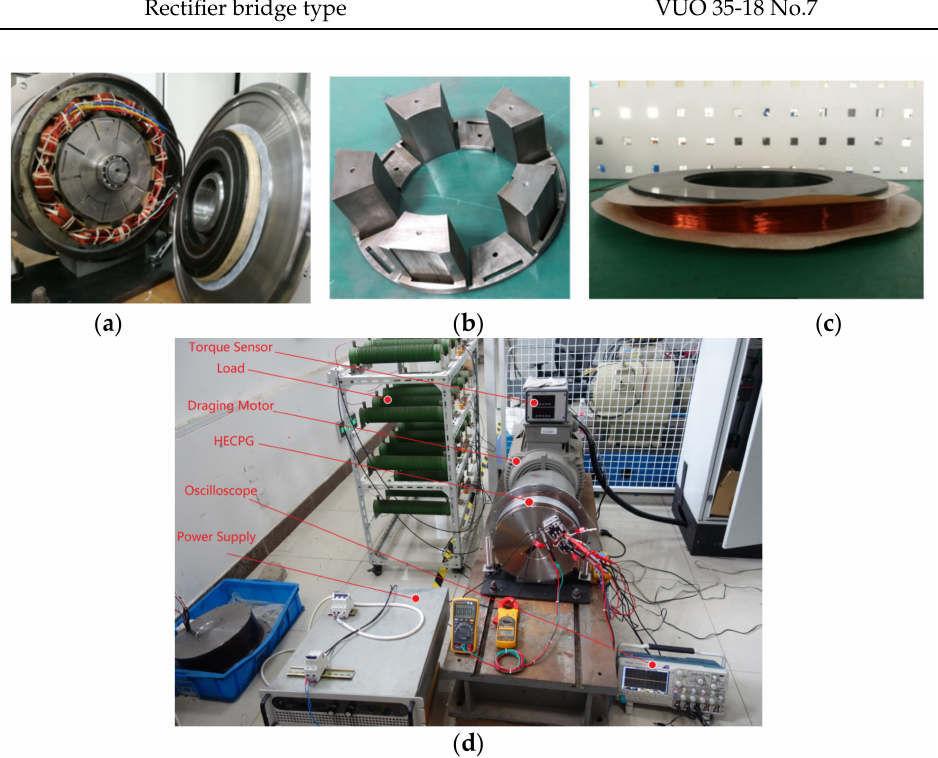
Figure 10. Prototype: ( a ) integral structure; ( b ) claw pole rotor; ( c ) axial magnetic bridge; ( d ) test